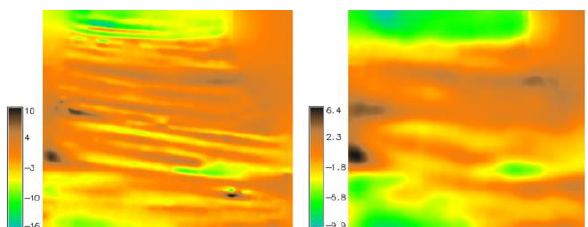
Figure 7. left image is elevation difference between bare earth lidar data and tension 40 smoothing 0 elevation model. Right image is elevation difference between bare earth lidar data and tension 10 smoothing 10 elevation